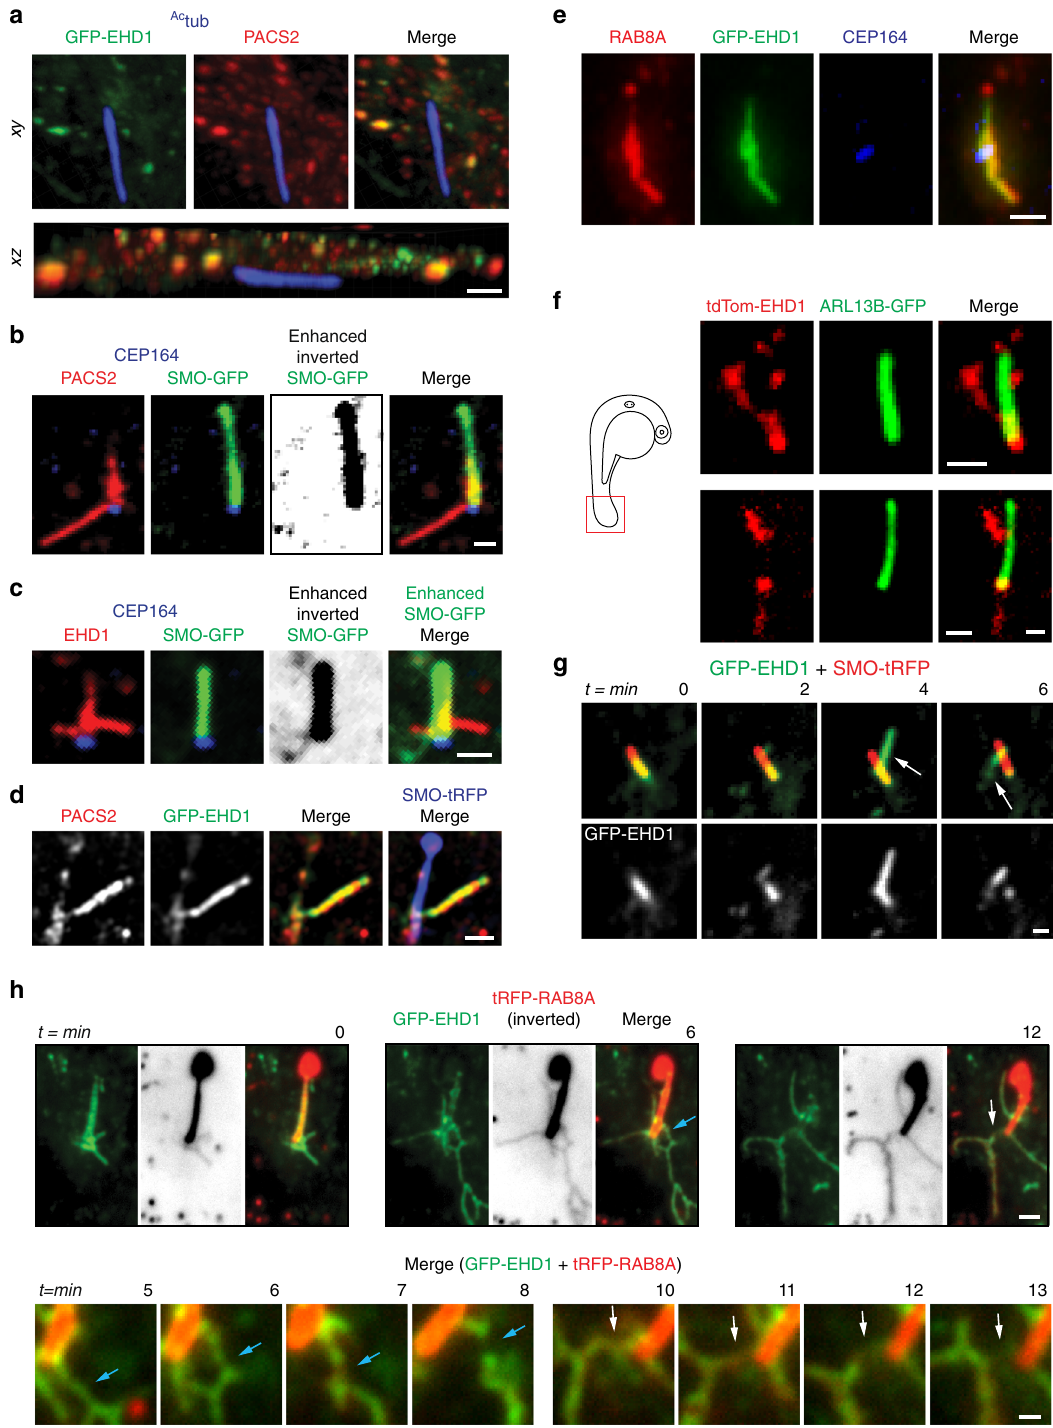
Supplementary Figure 3f, and 5d, e). By time-lapse imaging and using a cell line expressing GFP-EHD1, SNAP-CENTRIN1 to mark the centrioles, and SMO-tRFP (triple line), we determined that membrane tubules assemble and disassemble during ciliary formation (Fig. 6i). These fi ndings indicate that PACSINs localize to preciliary membranes, likely DAVs and/or CVs, and are associated with dynamic membrane tubules near the MC along with EHD1 during ciliogenesis.